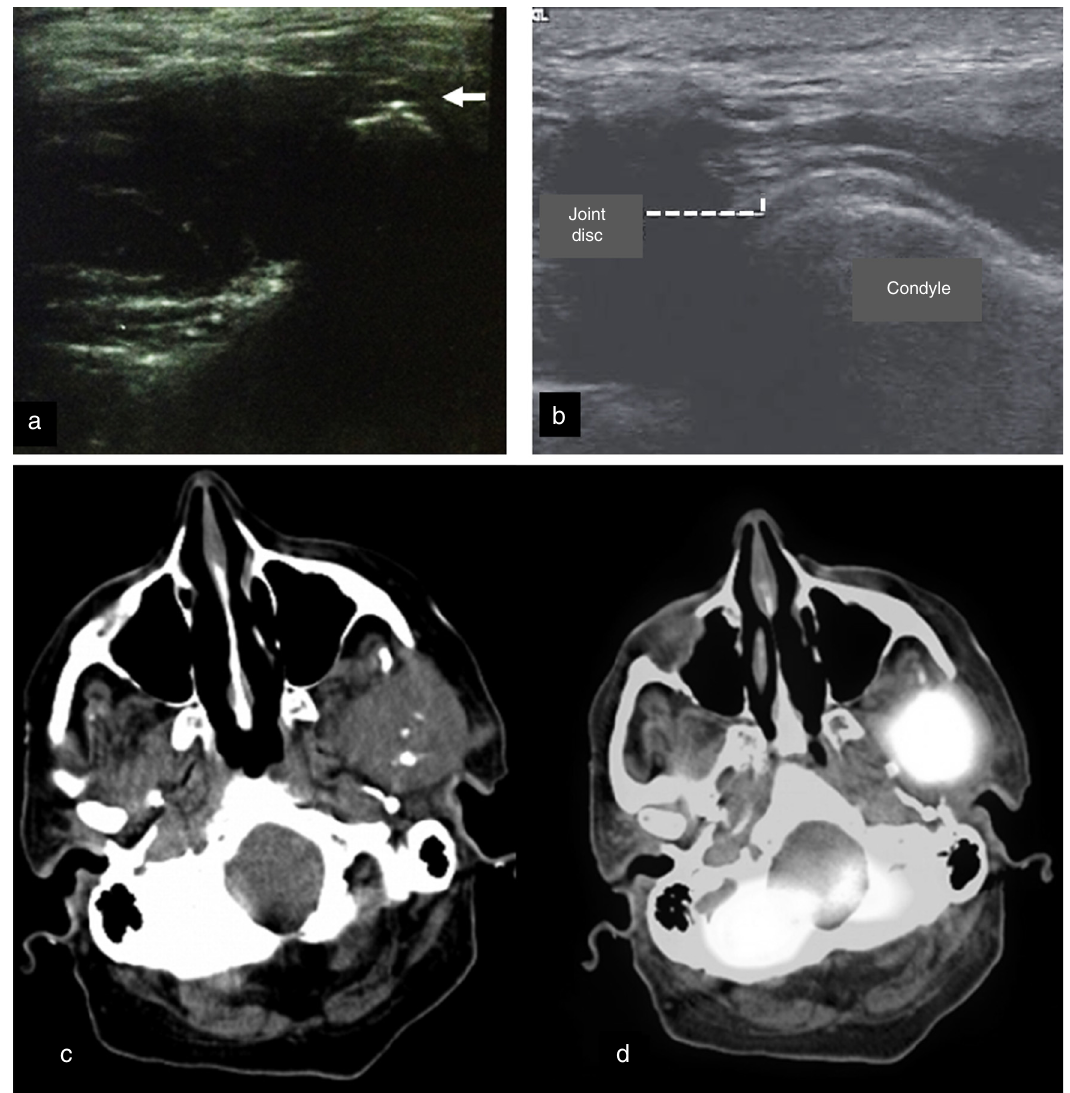
Other imaging techniques. (a) Ultrasound examination of the TMJ 25 used during the arthrocentesis assessment. Note the arthrocentesis needle as a hyperechoic point (white arrow). (b) Ultrasound examination of the TMJ showing the joint disc and condyle. (c) Tomographic axial view 28 showing mass of soft tissue growth in the left TMJ region extending to the ipsilateral pterygoid region. Infra-temporal space with absence of condylar process, the presence of hyperdense areas, swelling, and asymmetry. (d) PET/CT assessment in axial view 28 showing high metabolic activity in the left TMJ region. Images reproduced with permission of the authors’ copyrights 25,28 by